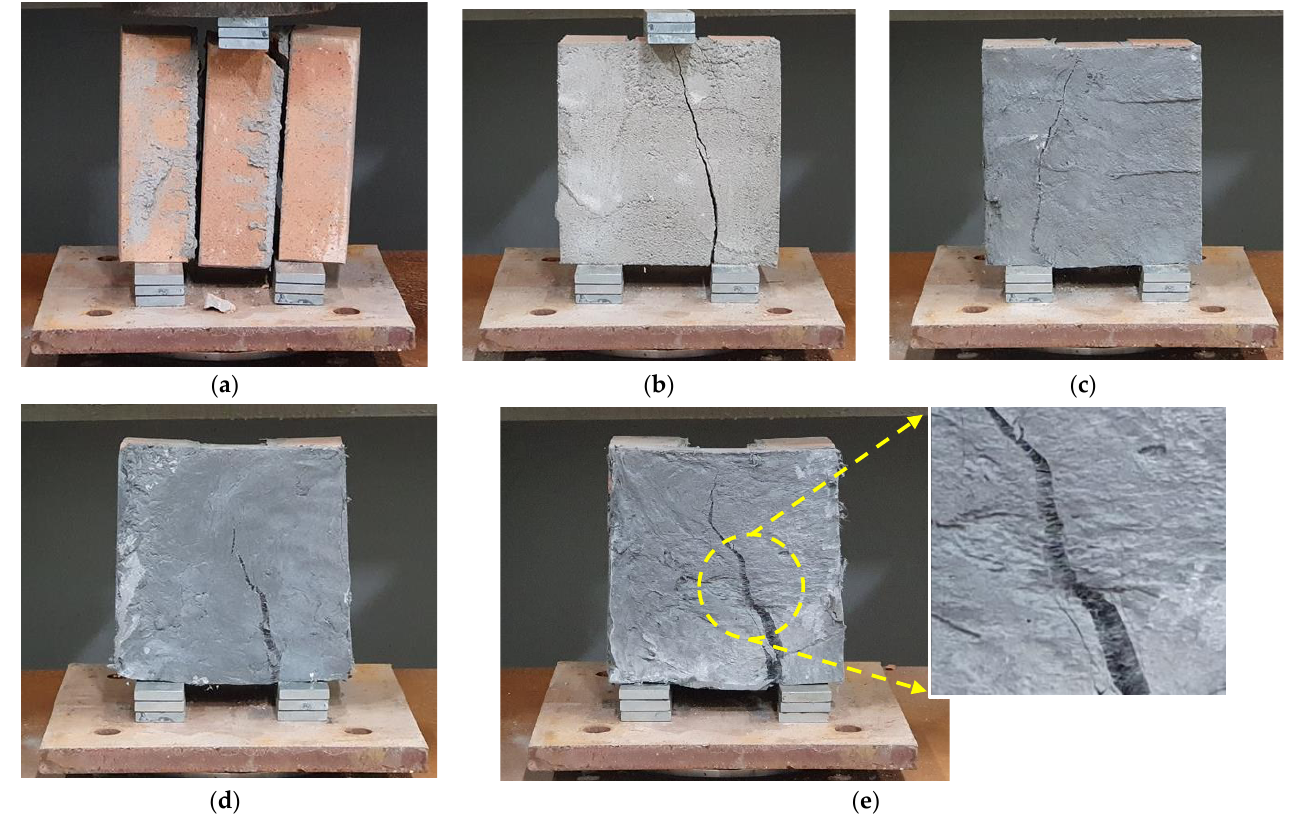
Figure 11. Failure mode for initial shear strength test: ( a ) SR; ( b ) SM10; ( c ) SH10; ( d ) SH20; ( e ) SH30.